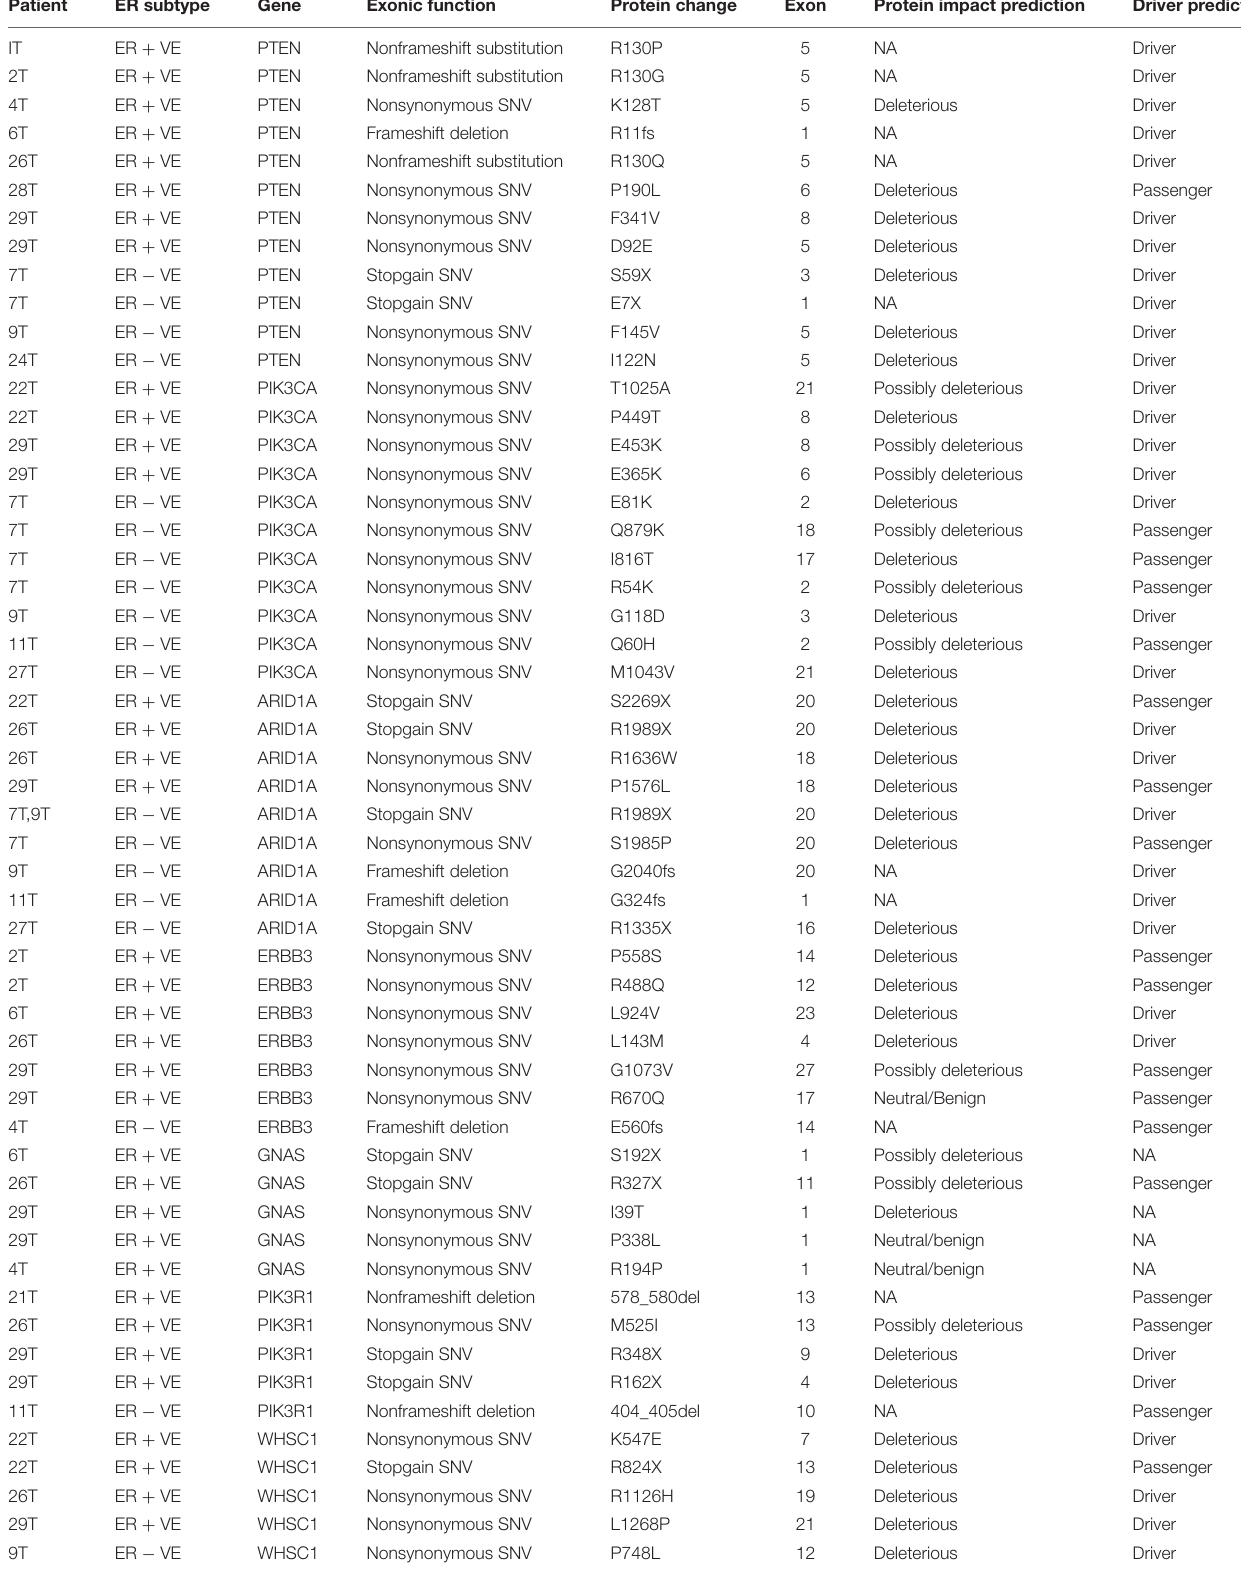
TABLE 2 | Classification of somatic alterations in PTEN, PIK3CA, ARID1A, ERBB3, GNAS, PIK3R1, and WHSC1 genes.